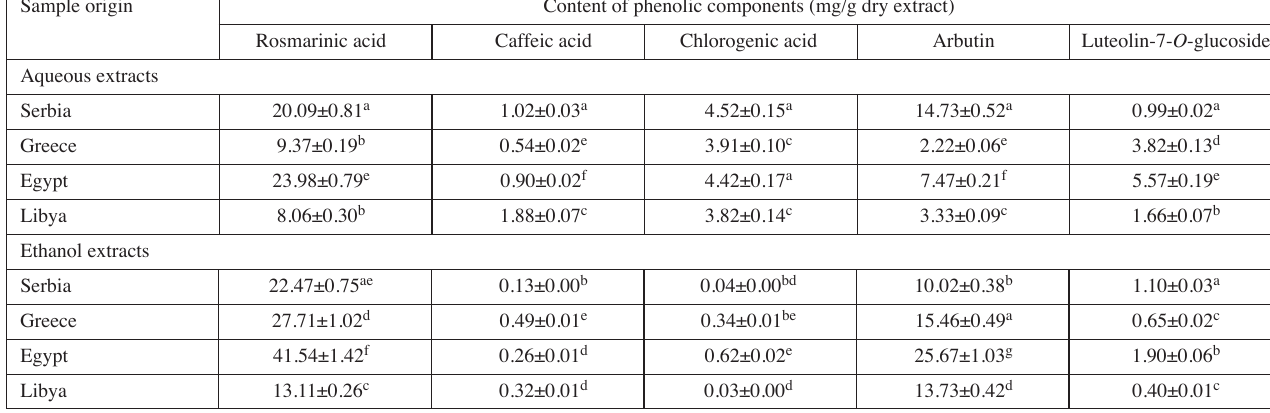
Tab. 2: Phenolic components identified in O. majorana extracts Sample